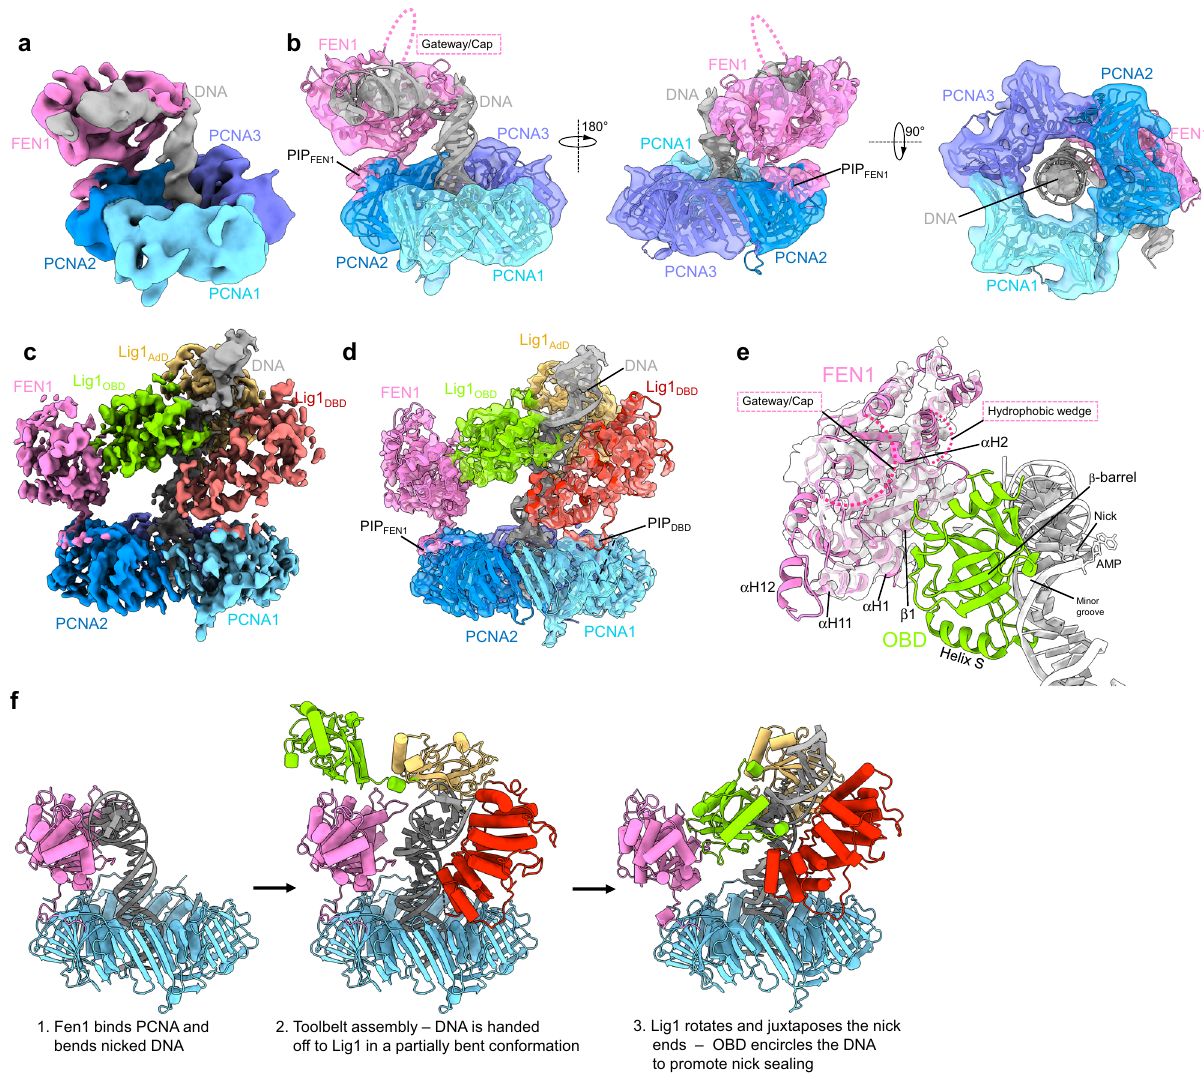
Fig. 5 | Cryo-EM structures of FEN1 – DNA – PCNA and Lig1 – DNA – PCNA – FEN1 complexes. a Cryo-EM density map of the FEN1 – DNA – PCNA complex colored by domains. b Three views of the cryo-EM density map of the FEN1 – DNA – PCNA complex with fi tted model. c Two views of the cryo-EM density map of the Lig1 – DNA – PCNA – FEN1 complex colored by domains. d Model of the complex in ribbonrepresentation fi